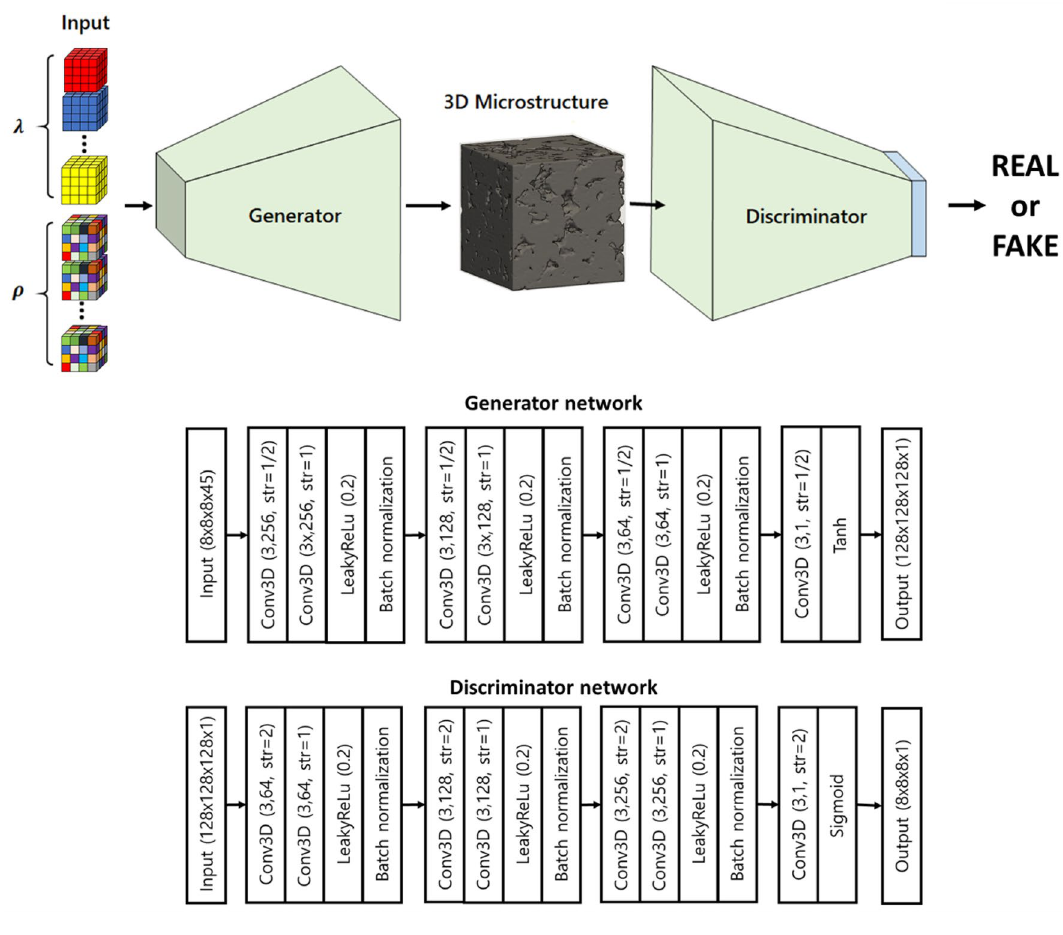
Figure 2. An overview of the 3D GAN